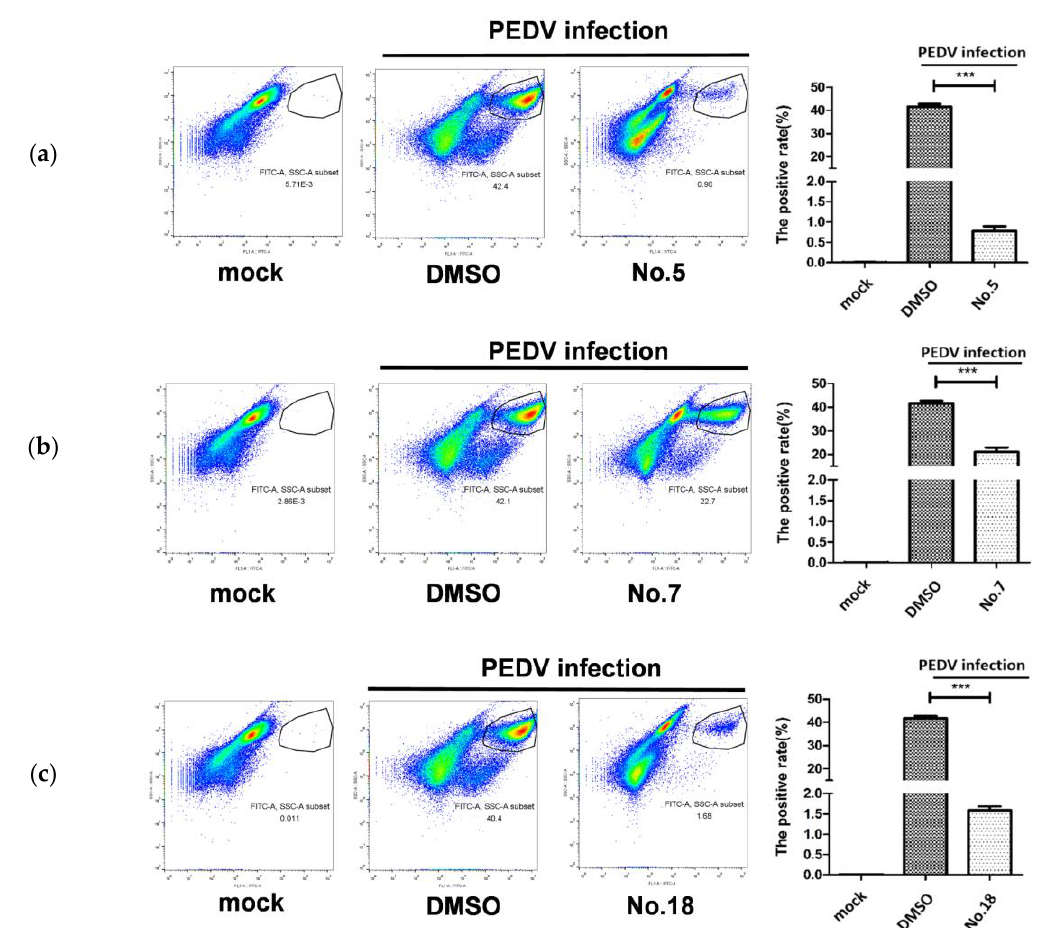
Figure 3. No.5, No.7, and No.18 carbazole derivatives were confirmed to anti-PEDV replication. ( a – c ) The vero-81 cells were incubated with No.5 ( a ), No.7 ( b ), or No.18 ( c ) carbazole derivatives at a concentration of 10 µM/mL for 1 h, and then infected EGFP-PEDV for 24 h. The fluorescence was analyzed by flow cytometry. *** p < 0.001.